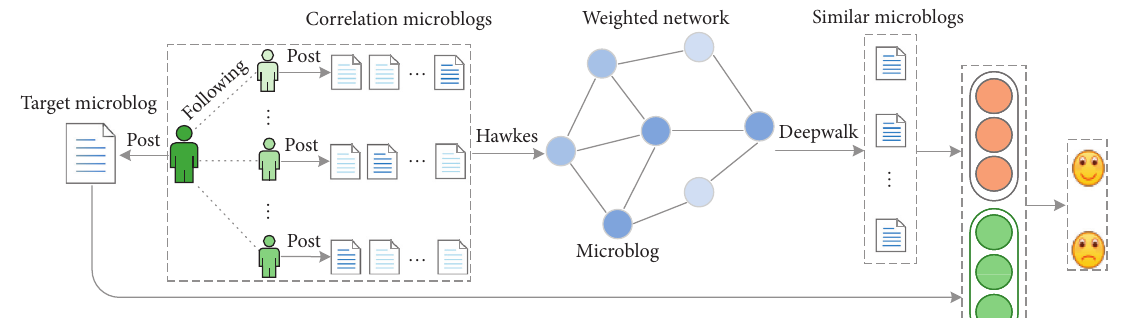
Figure 1: Overview of the proposed